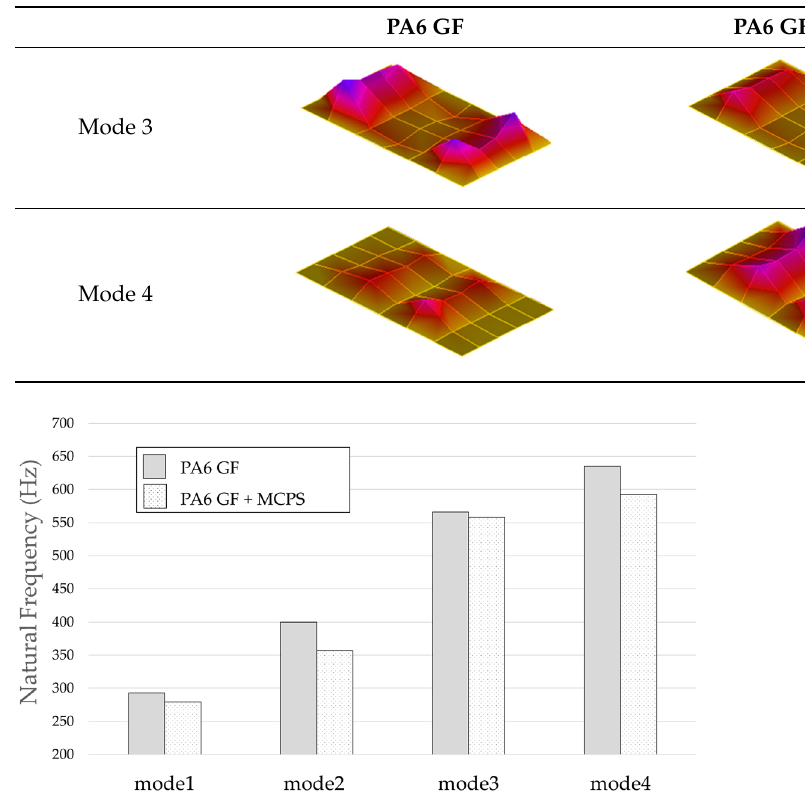
Table 3. Cont. Figure 10. Vibration response summation of plate specimen.